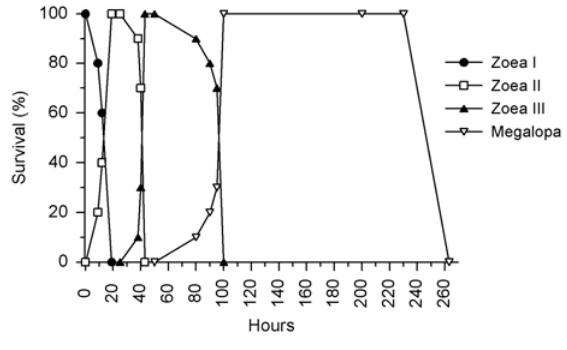
Fig. 9 – Survival (%) and intermoulting period (hours after hatching) of Lepidophthalmussiriboia larvaerearedinthelaboratoryandsubmit- ted to an initial starvation period. In this treatment, they were starved during 3